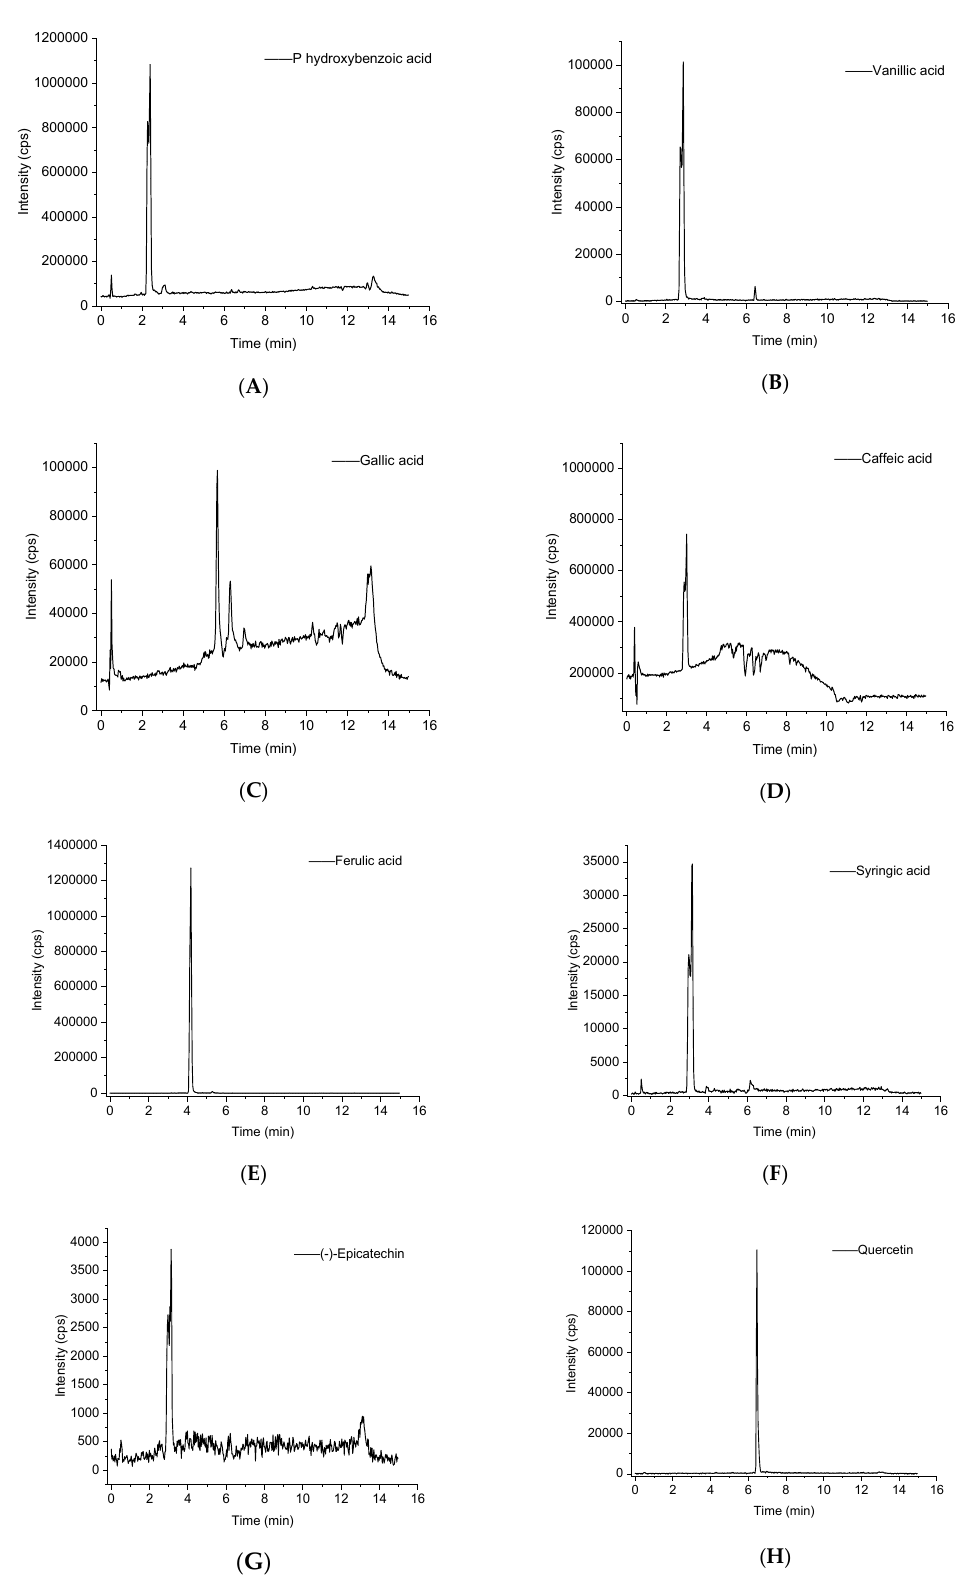
Figure 11. UPLC-MS multiple reaction monitoring (MRM) ion chromatograms of the eight phenolic compounds analyzed: ( A ) p-hydroxybenzoic acid, ( B ) vanillic acid, ( C ) gallic acid, ( D ) caffeic acid, ( E ) ferulic acid, ( F ) syringic acid, ( G ) ( − )-epicatechin, ( H )